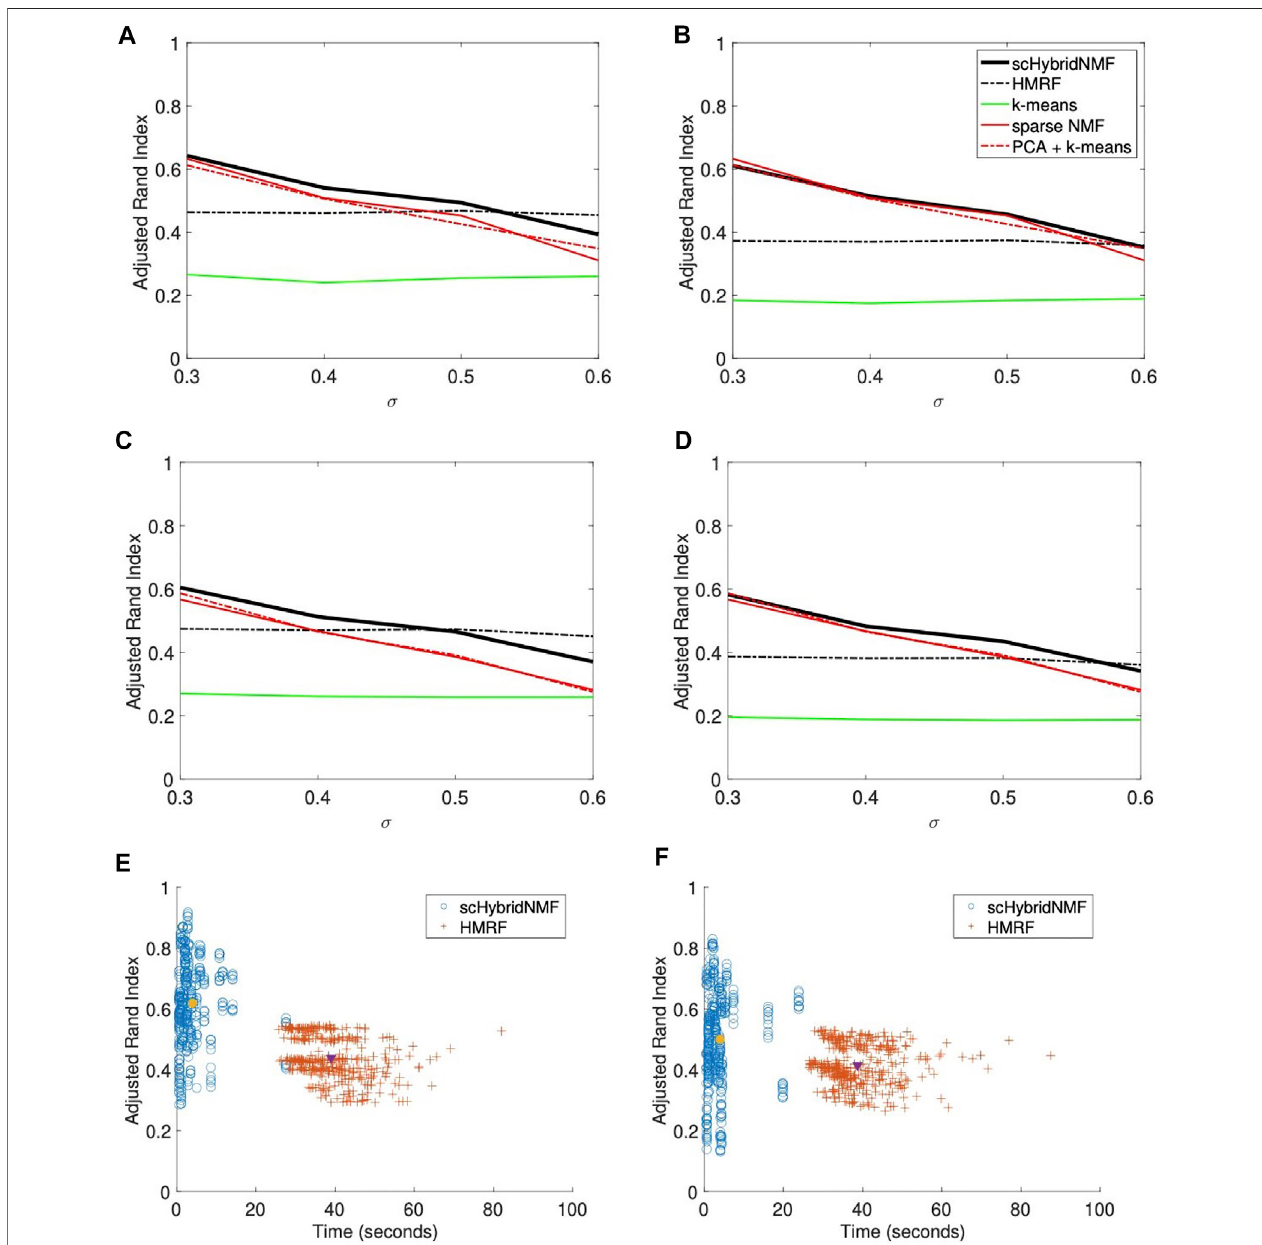
FIGURE 2 | (A – D) Performance vs sigma plots for location data with weak spatial patterns. Each plot shares the same legend as plot (B) . (A) No sampling, 20% noise. (B) No sampling, 30% noise. (C) 50% sampling, 20% noise. (D) 50% sampling, 30% noise. (E,F) Time vs performance dot plots of scHybridNMF and HMRF on gene expression data with no gene sampling and location data with strong and weak spatial patterns. (E) Strong spatial patterns. (F) Weak spatial patterns.